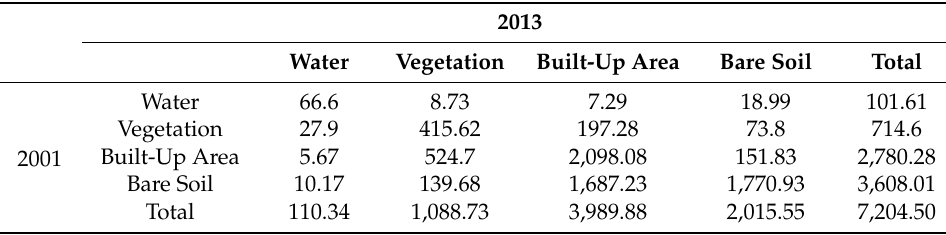
Table 7. Change detection matrix showing the class changes between 2001 and 2013.